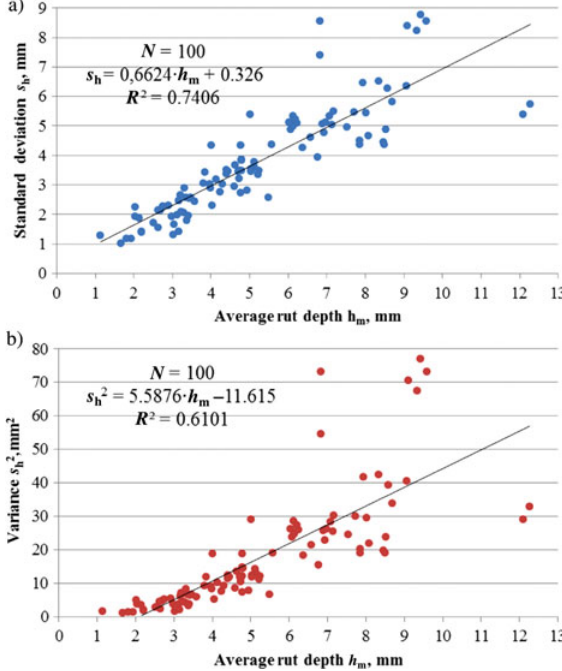
Fig. 5. The dependence of fraction indicators of rut depth on position indicators: a (cid:3) standard deviation and arithme- tical mean; b (cid:3) variance and arithmetical